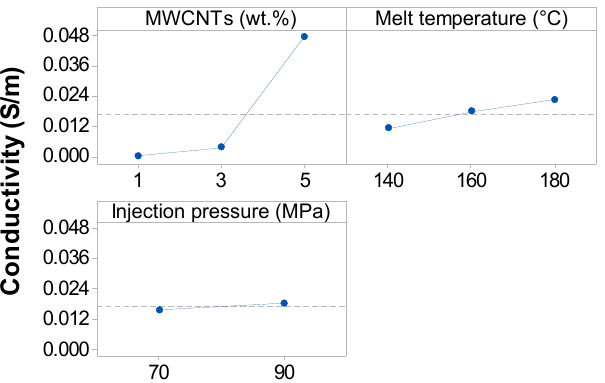
ff ect plots for electrical conductivity of EVA / MWCNT Figure 14. Main effect plots for electrical conductivity of EVA/MWCNT composite. Figure 14. Main e